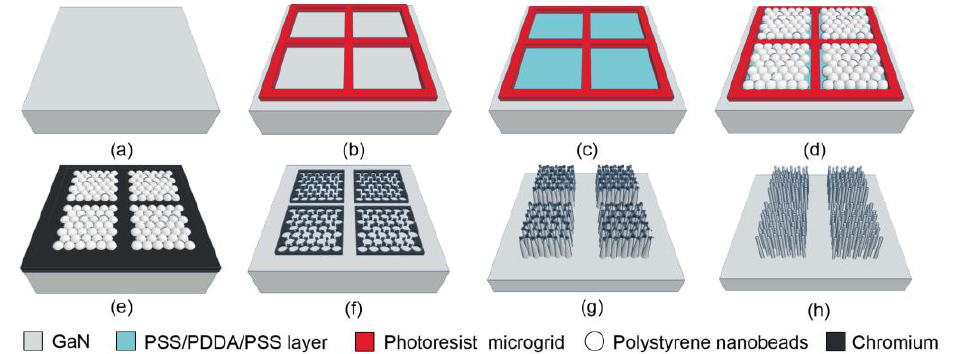
Figure 1. 3D GaN nanofabrication process sequences: ( a ) sample cleaning process; ( b ) fabrication